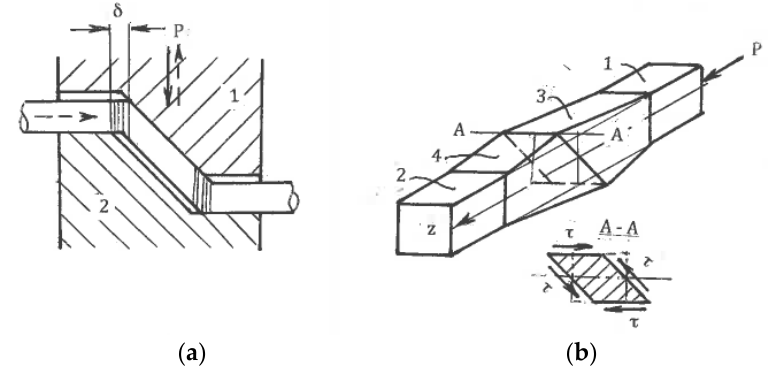
Figure 19. Equal-channel angular swaging ( a ) and “simple shear extrusion” ( b ).